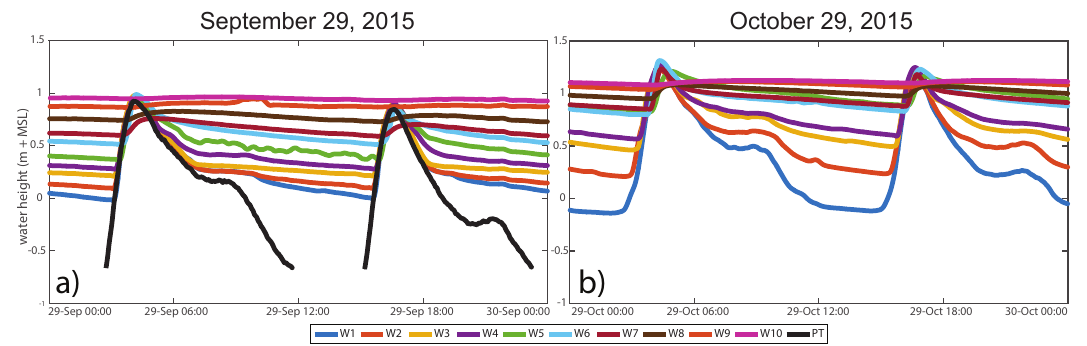
Figure 9. Time series of elevations on ( a ) 29 September 2015 and ( b ) on 29 October 2015. The different line colors represent different pressure transducers W1 (sea) to W10 (dune foot). On 29 September, the pressure transducer in the sea which measures tidal fluctuations was working properly and is represented by the black